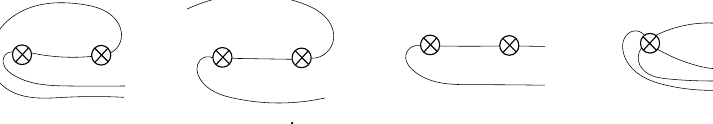
Figure 26. u i -straight arcs in S (cid:48)